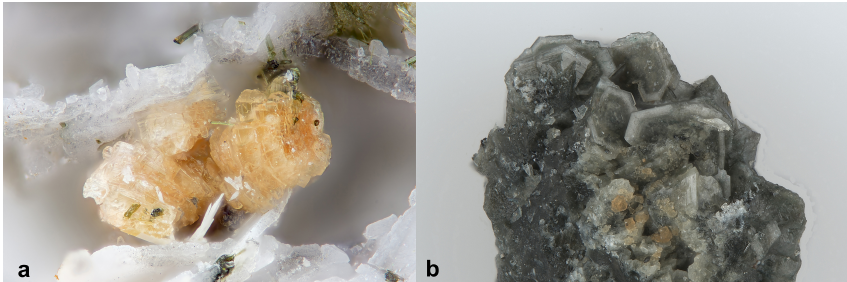
Figure 3. Alicewilsonite-(YCe): (a) orange-yellow transparent crystals from the Demix-Varennes quarry, Saint-Amable sill, Quebec, Canada. FOV 1.06mm. Specimen CMNMC 89822. Photo: Michael Bainbridge and (b) green-grey crystals from the Kirovskii mine, Kukisvumchorr mountains, Khibiny Massif, Kola Peninsula, Russia. FOV 1.5mm. Specimen CMNMC 90475. Photo: François Génier. Canadian Museum of Nature